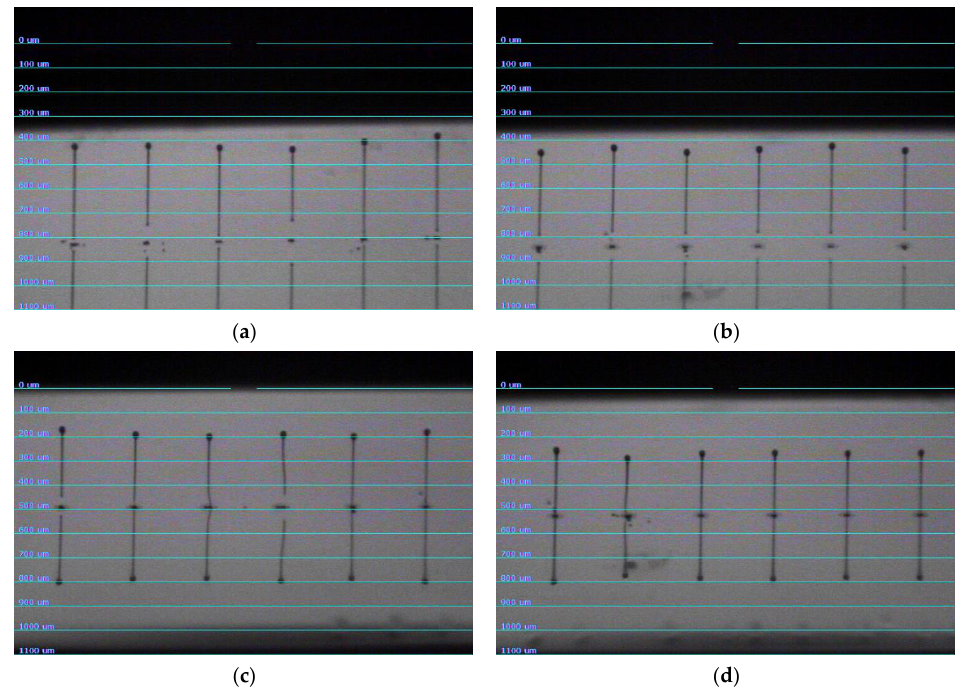
Figure A3. Ink jetting properties for the ink samples Unmodified ( a ), 13 III ( b ), 35 III ( c ) and 100 III ( d ).